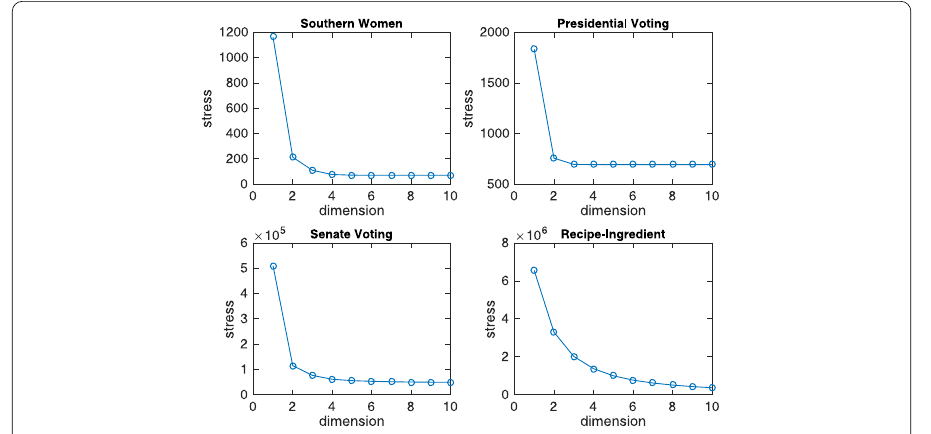
Figure 6 Minimal stress vs. dimension in BiFold. For each of the example dataset used in this paper, we plot the minimal BiFold stress obtained by the SMACOF algorithm (see MaterialsandMethods for details) as a function of the embedding